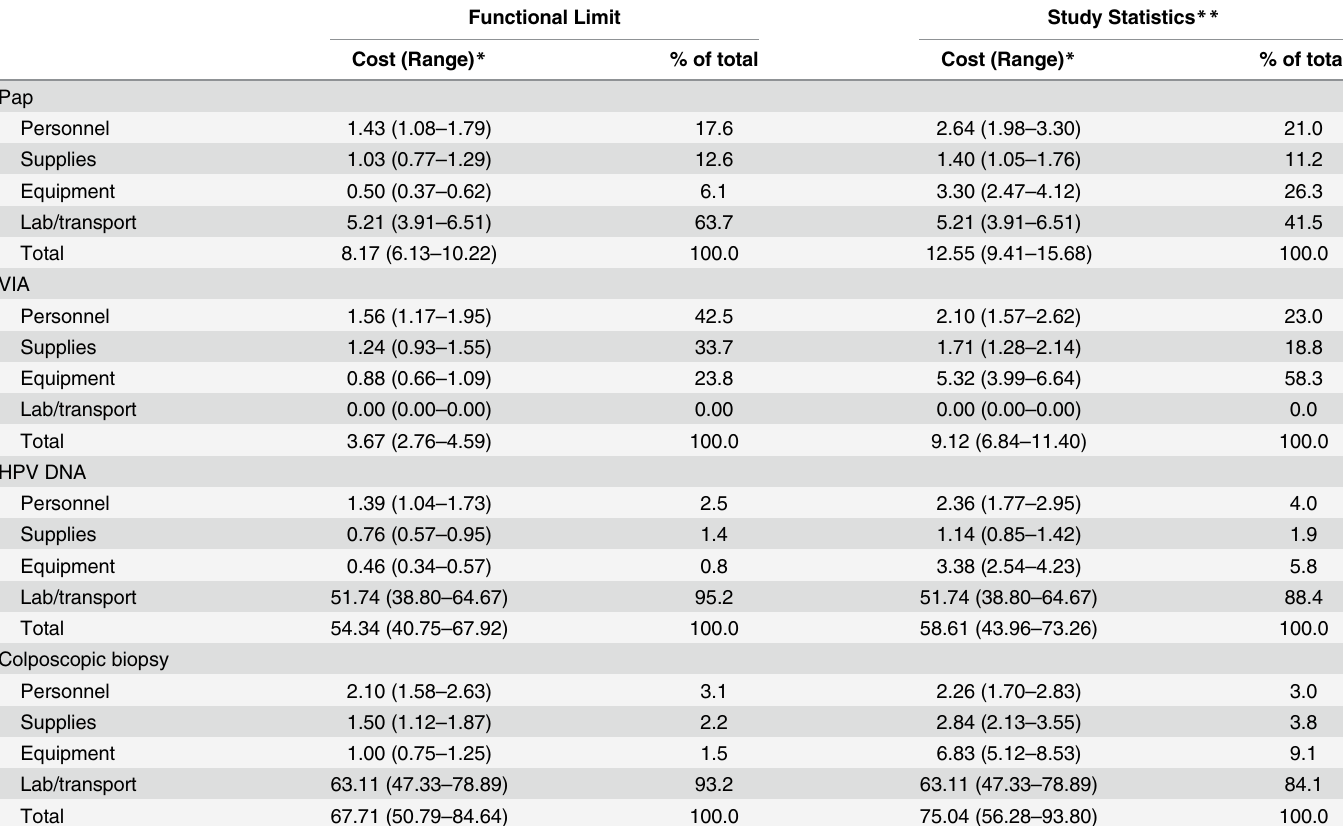
Table 3. Average estimated procedure costs for each scenario (USD 2013), cost ranges for sensitivity